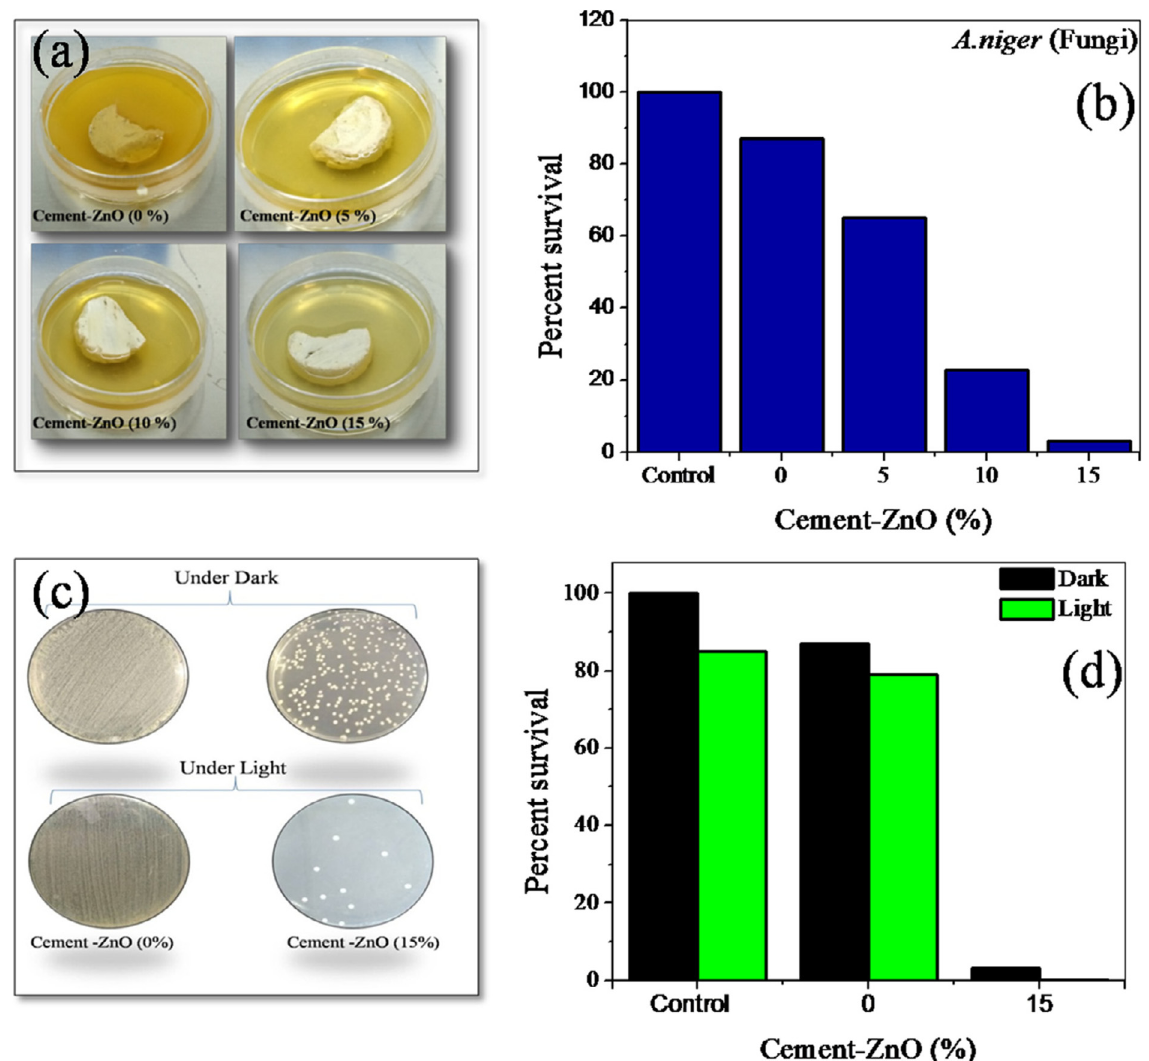
Figure 7. ( a ) Cement–ZnO composite bacterial disinfection E. coli and ( b ) B. subtilis. ( c ) Pictures of colony-forming E. coli on agar plate under dark and sunlight. ( d ) Percentage survival of bacteria on cement–ZnO composite was improved under sunlight (ref. [47]).